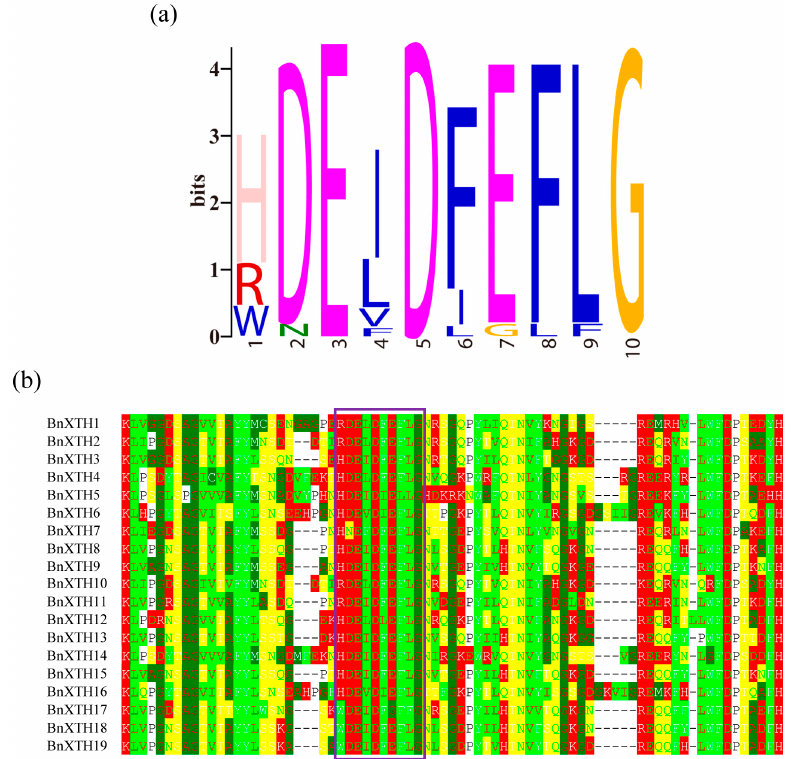
Figure 1. Phylogenetic tree showing the relationships among XTH proteins of Boehmeria nivea and those of Arabidopsis thaliana . The colored arcs show Groups I, II, IIIA, and IIIB. This phylogenetic tree was constructed via the neighbor-joining (NJ) method, using MEGA 6.06 with 1000 bootstrap replicates.